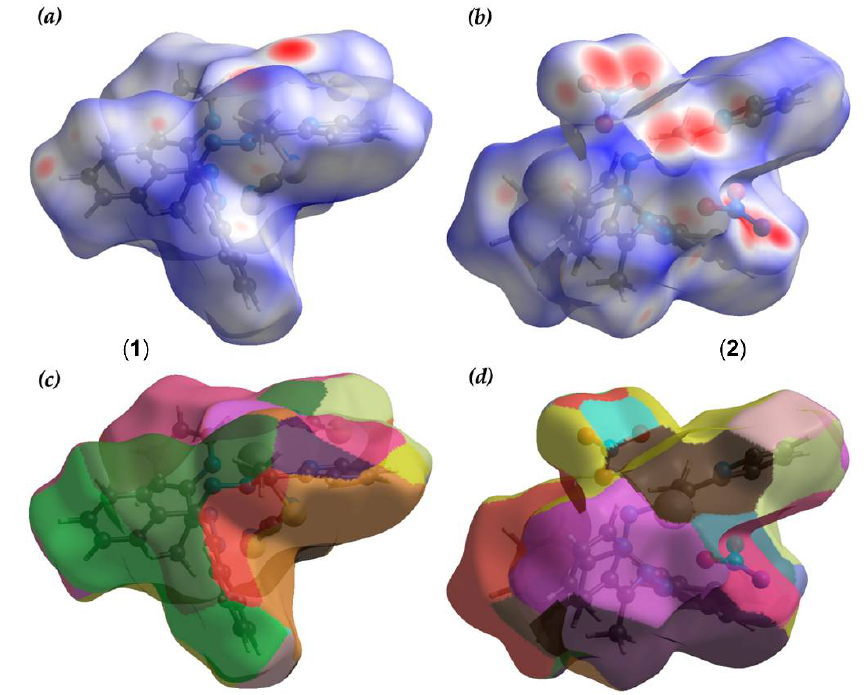
Figure 8. Hirshfeld surfaces mapped with d norm (( a ) and ( b )) and Fragment patches (( c ) and ( d )) for compounds ( 1 ) and ( 2 ), respectively.